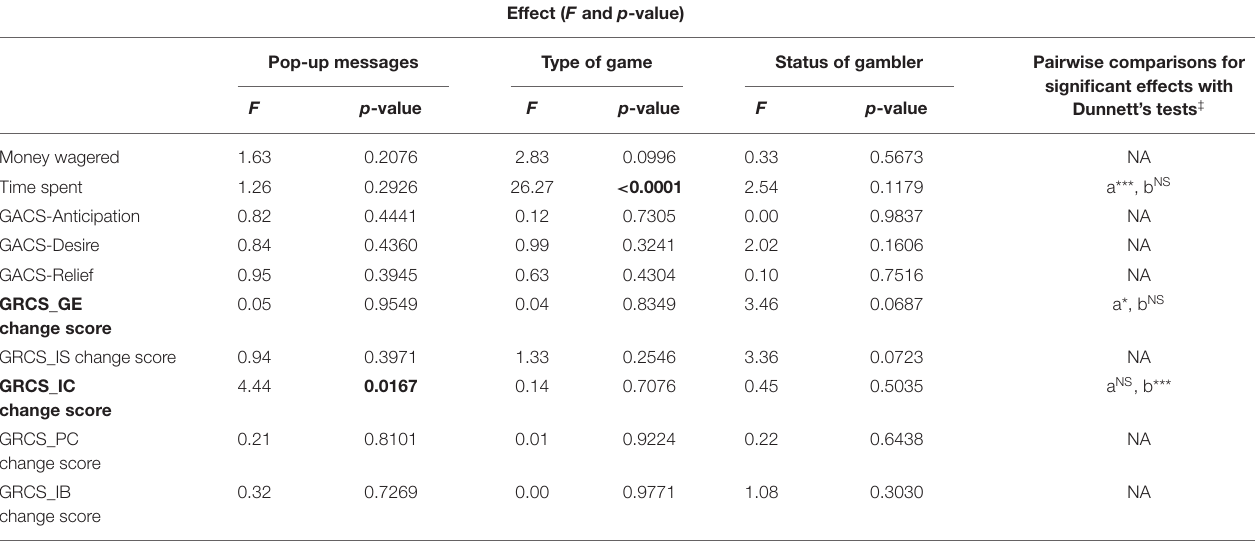
TABLE 3 | ANOVA results adjusted for the status of gamblers and the type of gambling comparing the 2 experimental conditions with the control condition for differences between the pre-test (T0) and 2nd post-test (T2). Effect ( F and p -value)